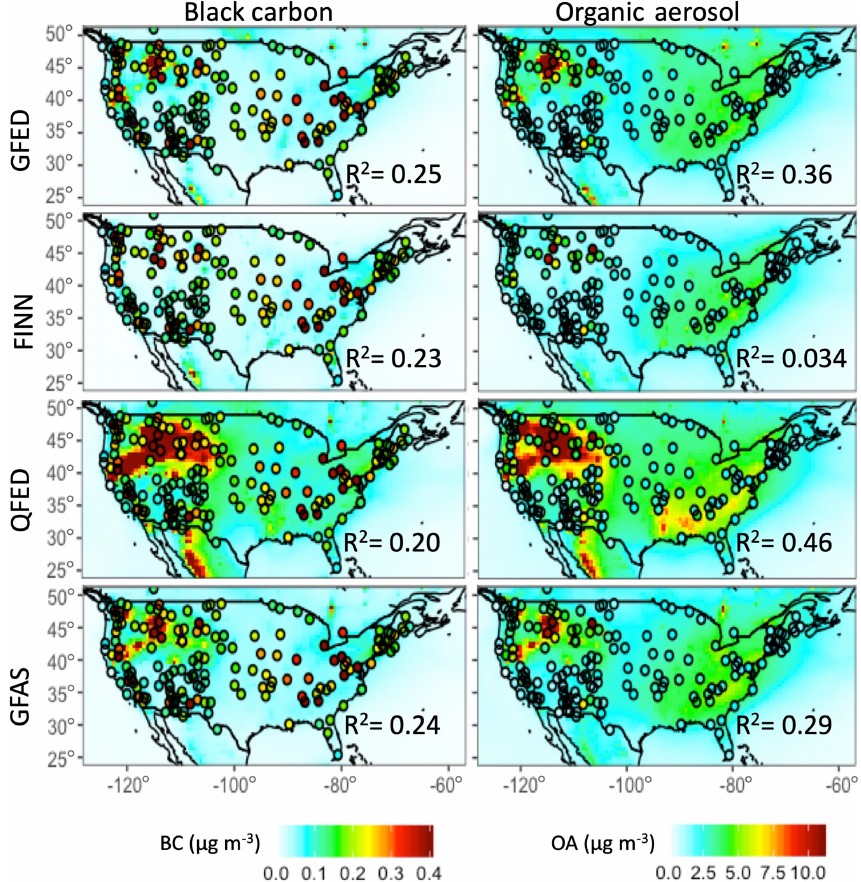
Figure 8. Fire season (May–September) 2012 mean surface BC and OA concentrations in CONUS with the model driven by each inventory. The circles show the mean observed surface concentrations at IMPROVE